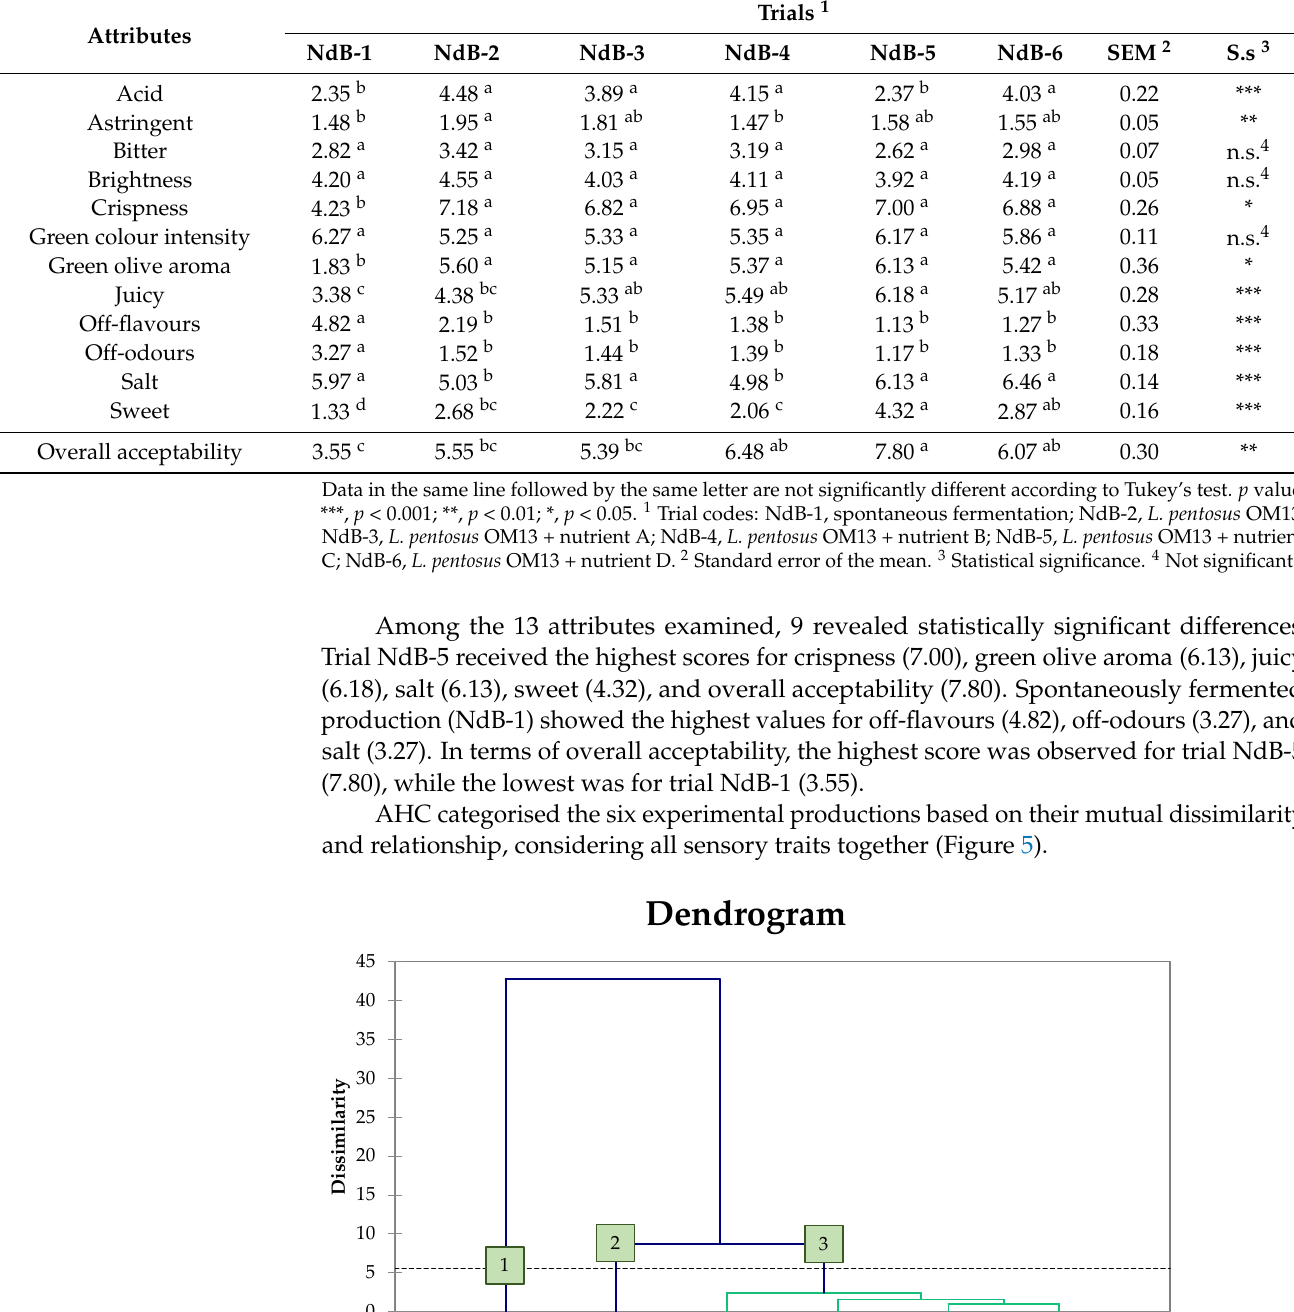
Table 4. Evaluation of the sensory attributes of the experimental table olives.